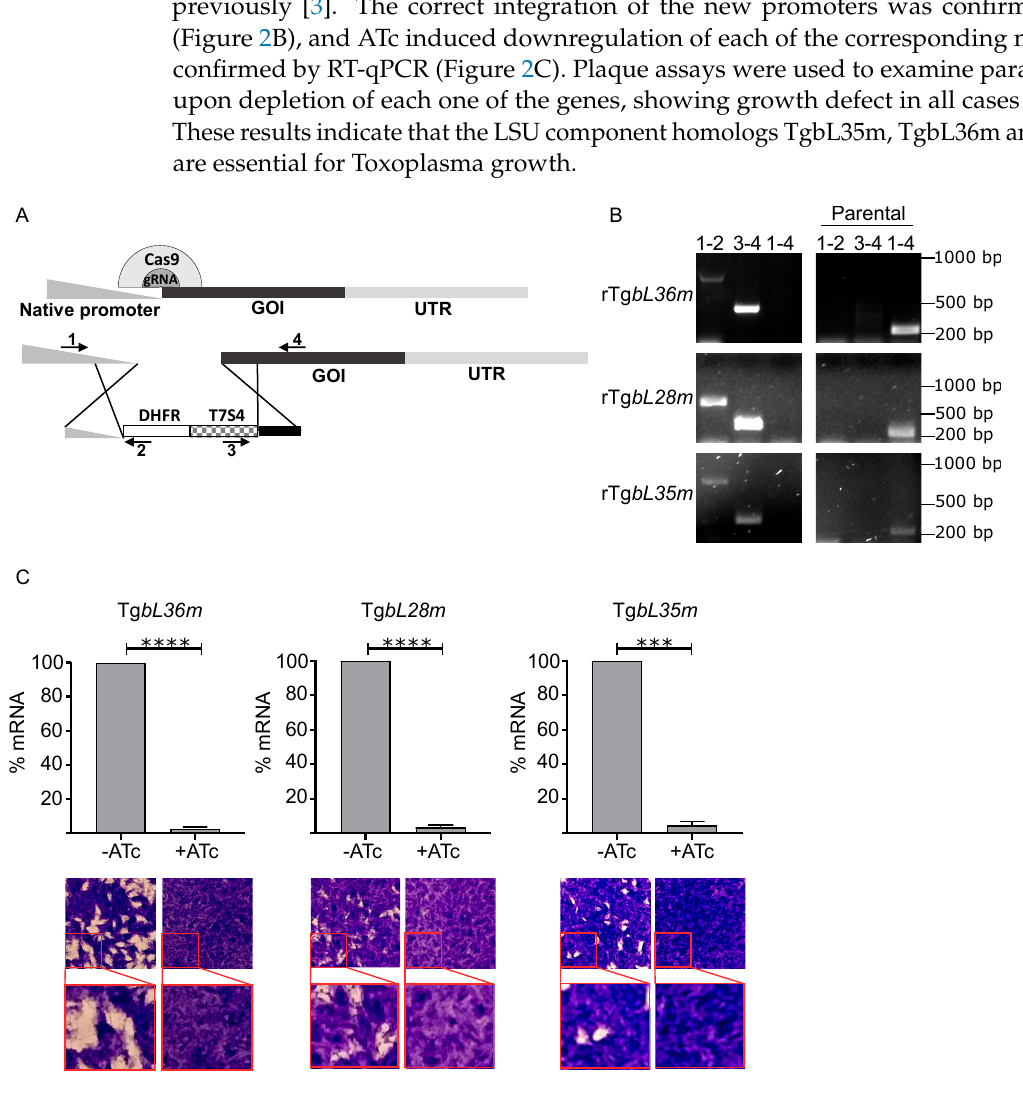
Figure 2. Toxoplasma LSU homologs are essential for parasite growth. ( A ) Scheme depicting the genetic manipulation leading to promoter replacement of genes mentioned in ( B ) and showing the location of the primers used in ( B ). ( B ) Validation of the repressible promoter integration in the Tg bL36m , Tg bL28m and Tg bL35m gene loci via PCR analysis using primers 1, 2, 3, and 4 shown in ( A ). ( C ) Bar graphs on the top show transcript levels of Tg bL36m , Tg bL28m and Tg bL35m , analysed by qRT-PCR, in absence ( − ATc) or presence (+ATc) of Anhydrotetracycline (ATc) after 48 h ( n = 3, bars represent mean ± SD, **** p < 0.0001, *** p = 0.0009; analysed using unpaired t -test). Images on